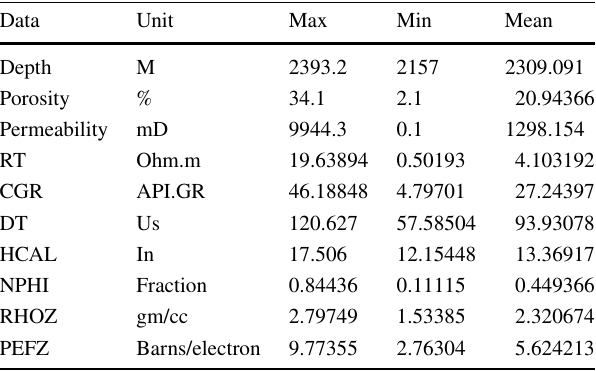
Table 2 Value range of available